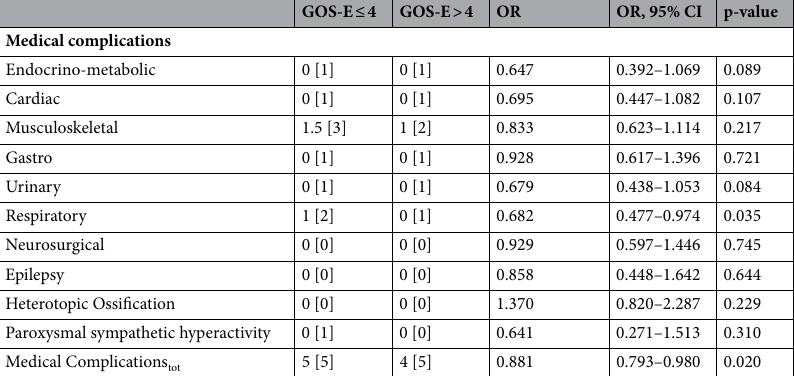
Table 2. Admission descriptive and inferential statistics for 3-months